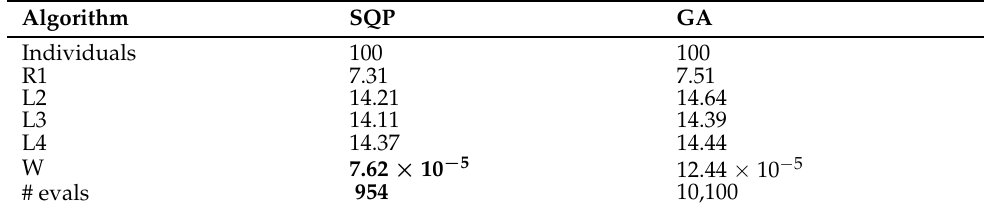
Table 7. TEAM Workshop Problem 25 optimization results.